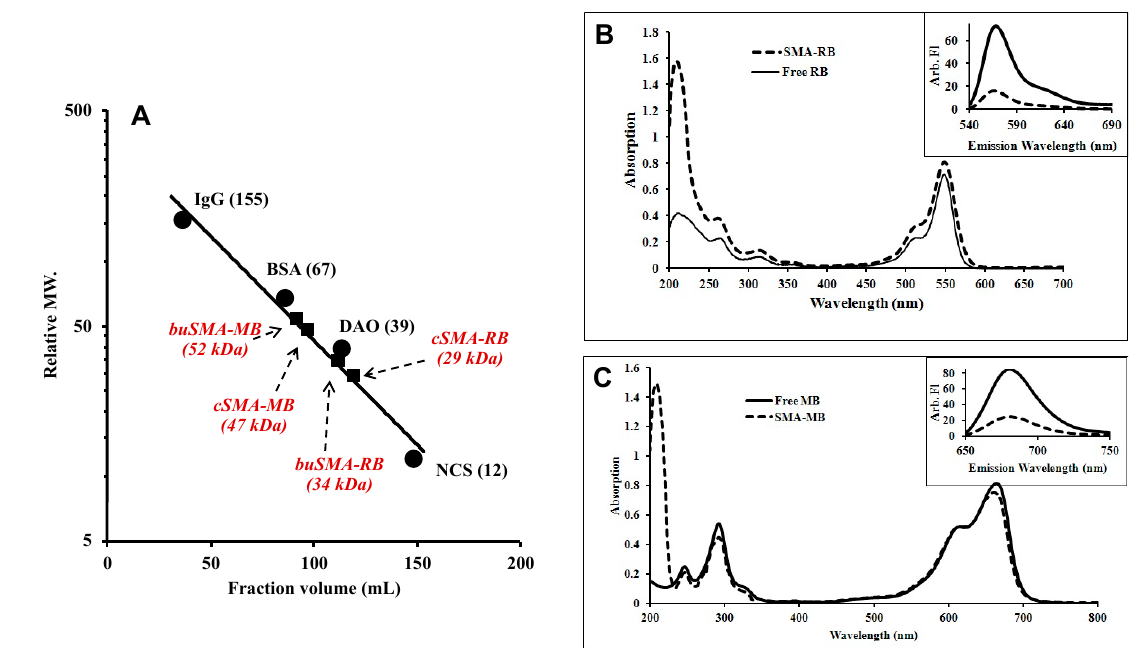
Figure 1. Sephadex superfine G-100 gel chromatography of SMA-PS micelle ( A ), and the absorption spectrums of free rose bengal (RB) vs. SMA-RB micelles ( B ) and free methylene blue (MB) vs. SMA- MB micelles ( C ). Size-exclusion chromatography of SMA-PS micelles was carried out with various known molecular weight proteins as a reference standard; a 3.2 mL fraction was collected per tube and 0.2 M sodium phosphate buffer (pH 7.4) was used as eluent. The absorption spectrums were recorded at 0.8 μ g/mL concentration of Photosensitizers (PSs) equivalent on UV/vis in a 0.1 M phos- phate buffer (pH 7.4). Insets of ( B ) and ( C ) show the fluorescence spectra of PSs and SMA-PS mi- celles.